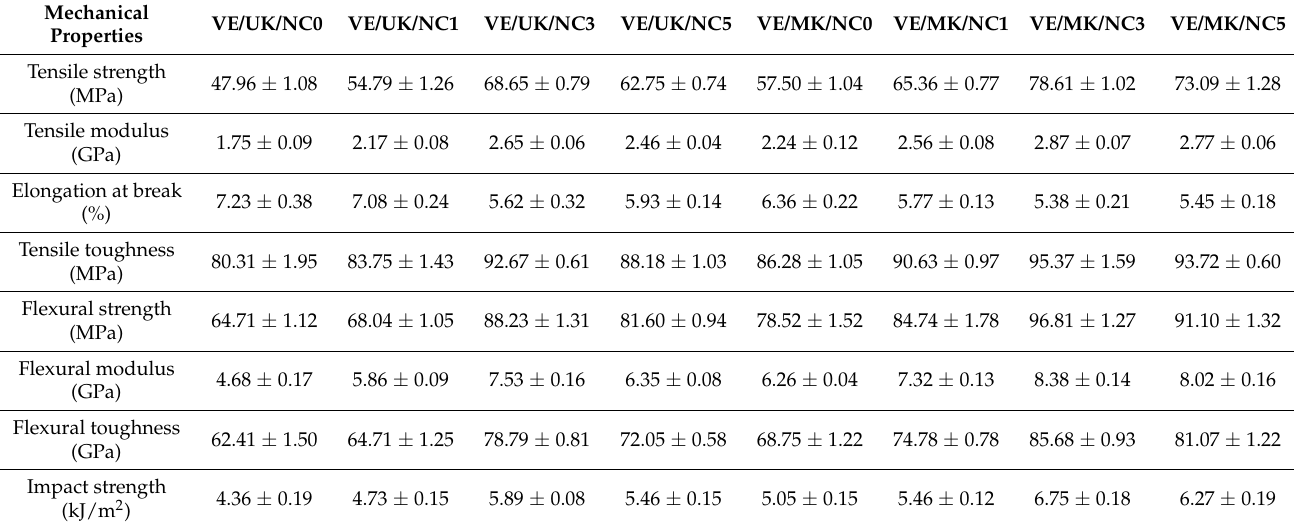
Figure 7. Water absorption and swelling properties of unmodified and modified kenaf reinforced nanocomposite. Table 1. Mechanical properties of unmodified and modified kenaf reinforced